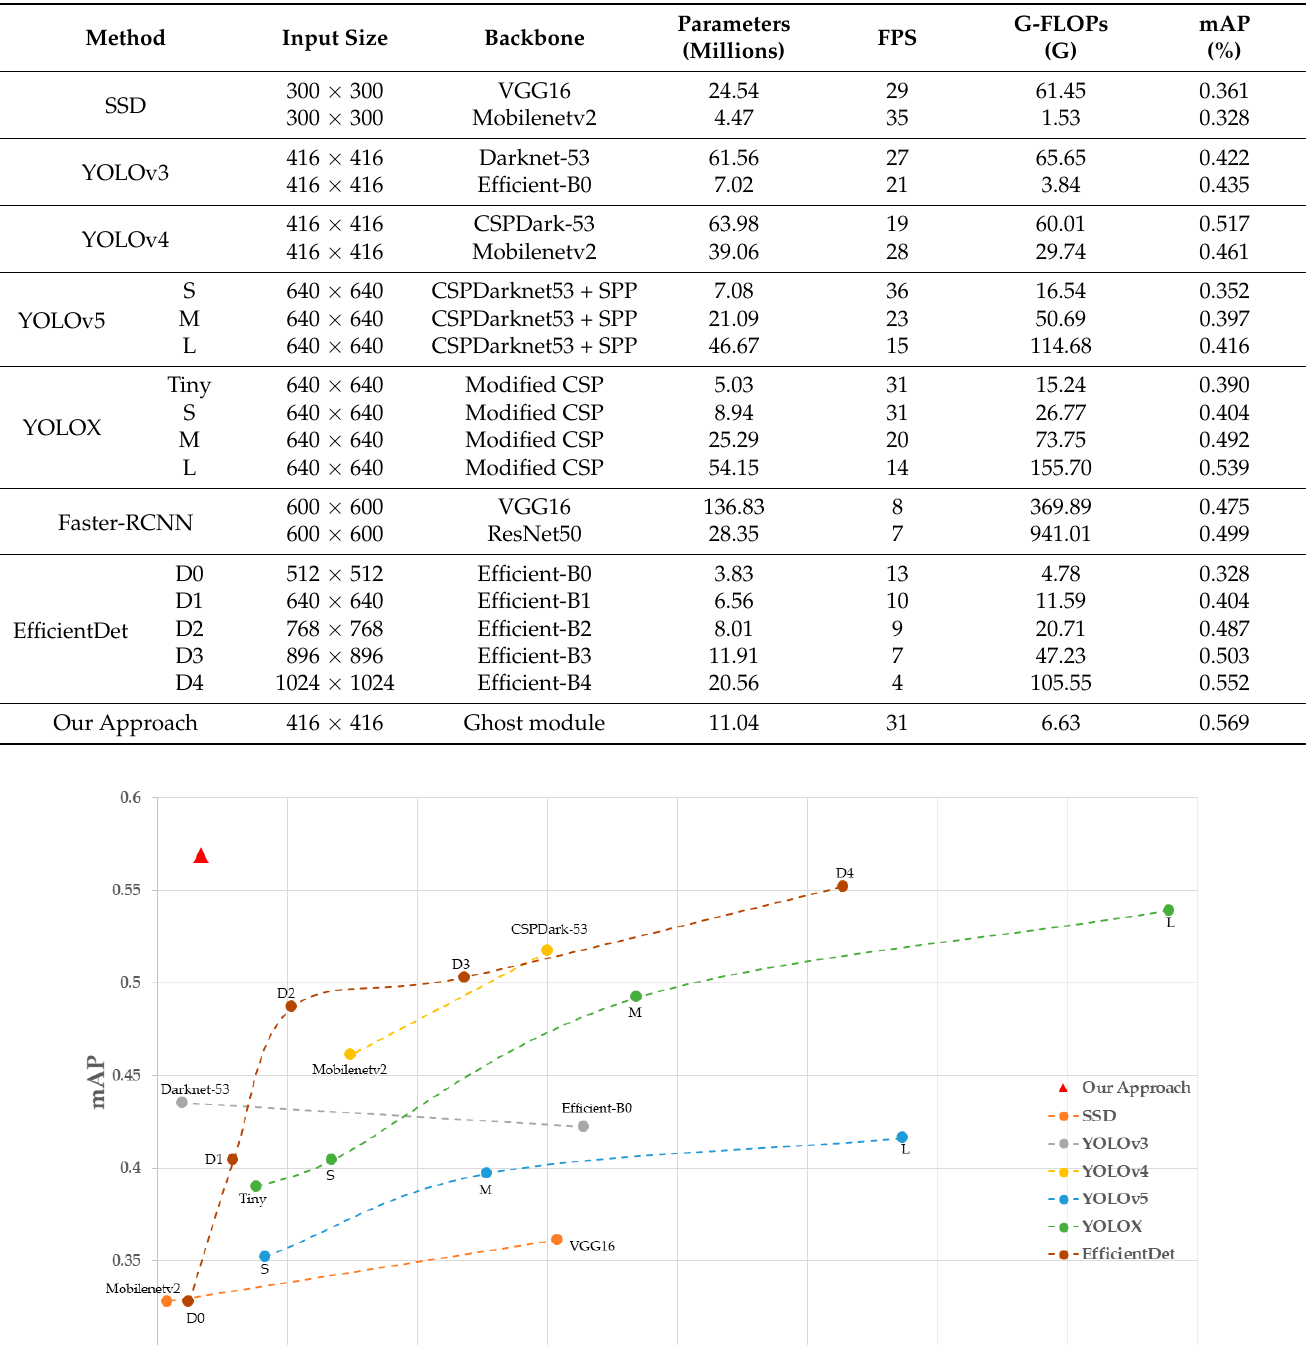
Table 11. Comparison of the proposed method with SSD, Faster-RCNN, YOLO series, and EfficientDet on the same dataset.